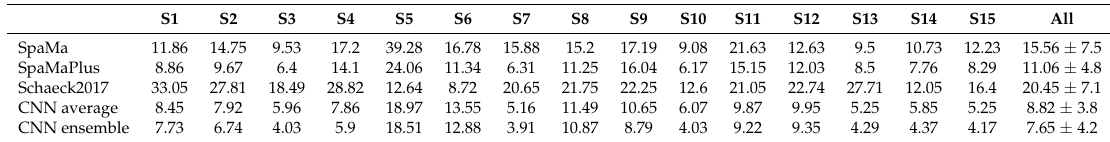
Table 10. Session-wise evaluation results on the dataset PPG-DaLiA , achieved with the three classical methods and the best performing CNN architecture (ensemble prediction; results averaging the 7 repetitions are given for comparison). Results are given as MAE [bpm].